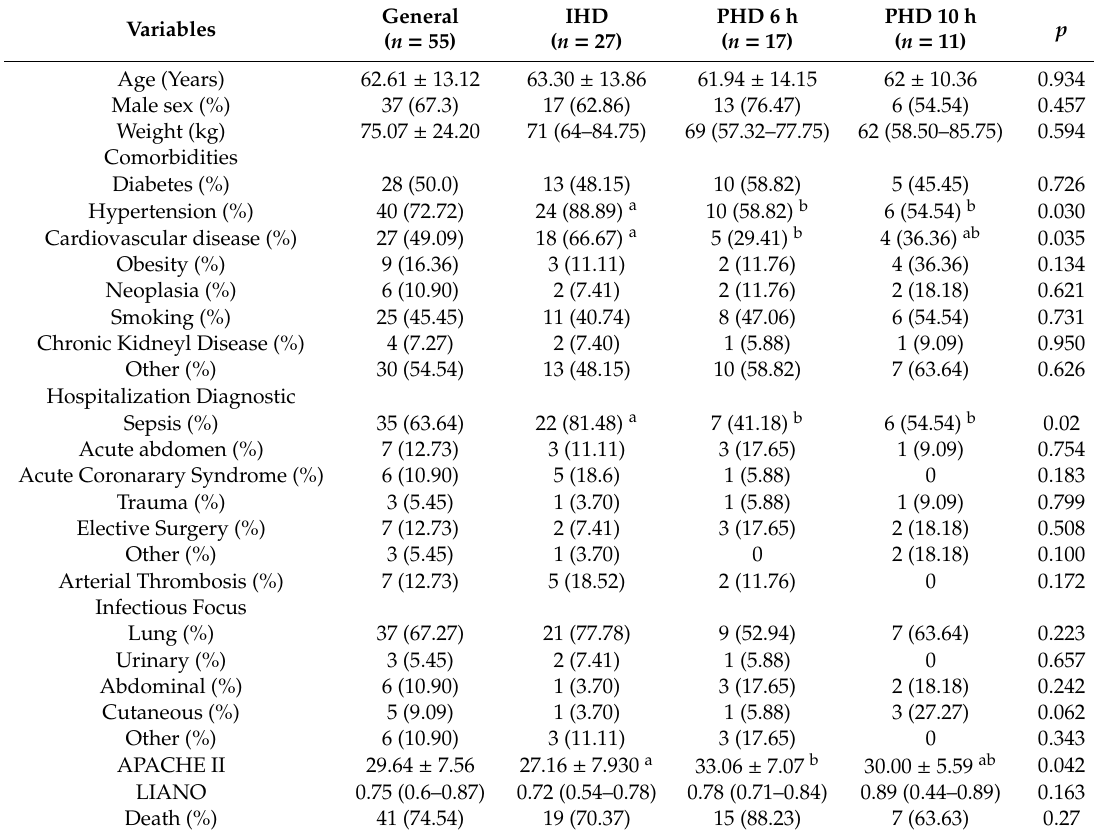
Table 2. Clinical characteristics of the general population and of the groups according to the di ff erent dialytic treatments.